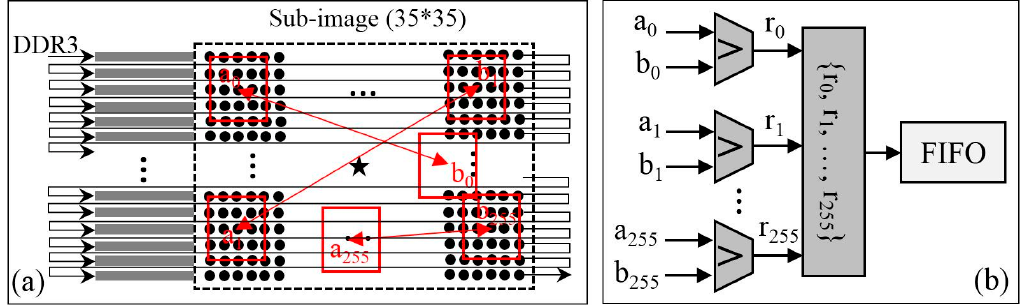
Figure 8. ( a ) A sub-image extraction by line-buffer; ( b ) generation of a BRIEF descriptor.